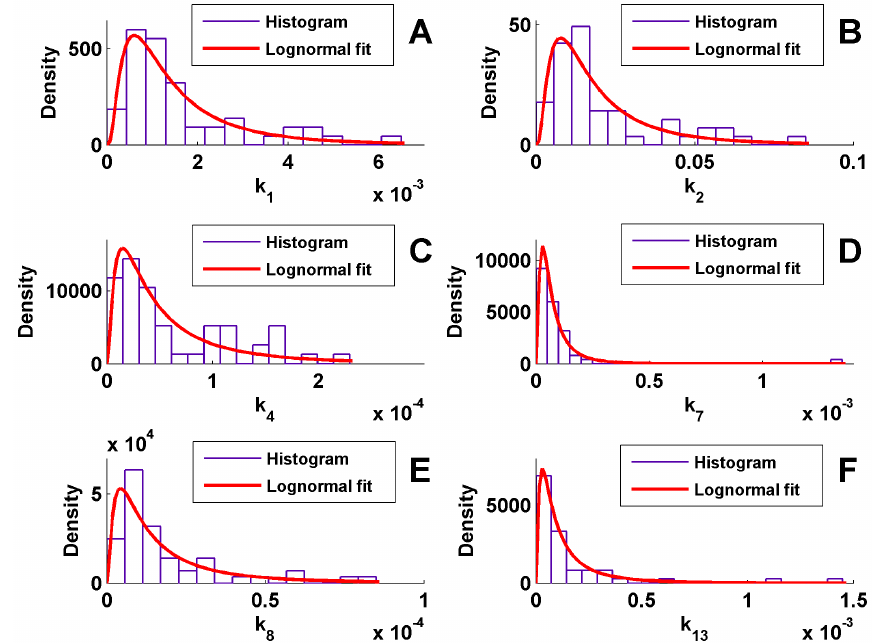
Figure 3. Distribution of the reaction coefficient. Coefficients k 1 (A), k 2 (B), k 4 (C), k 7 (D), k 8 (E) and k 13 (F), obtained with our stochastic procedure; the best fit is achieved by means of Log-normal distribution comparing the